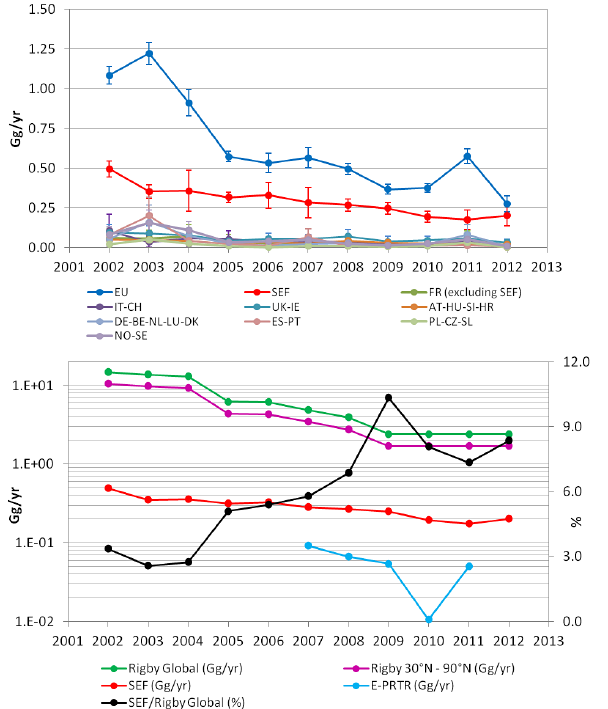
Figure 5. Top: trends in MCF estimated emissions over the whole study period derived from the Bayesian inversion. The blue curve (EU) represents total emissions from the study domain, i.e. the sum of emissions from SEF region and other European group of countries. Bottom: comparison of our estimated emissions from the SEF region (red) with the E-PRTR data for SEF (light blue), global (green) and semi-hemispheric (purple) emissions as reported in Rigby et al. (2013). The black curve is the fraction with respect to the global emissions represented by the emissions derived from the inversion for the SEF region (right axis).